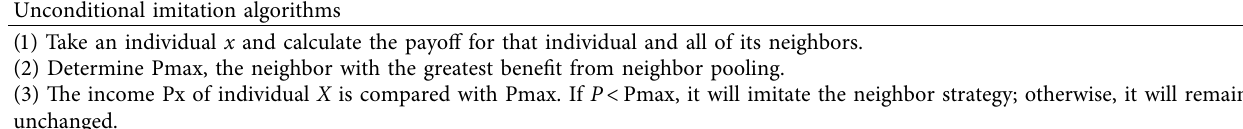
Table 1: Unconditional imitation algorithms.